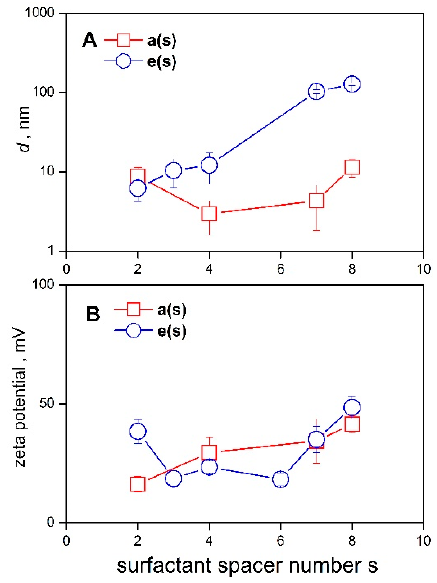
Figure 5. A : Micelle hydrodynamic diameter d of a(s) and e(s) gemini surfactants plotted as a function of surfactant spacer number s , at the surfactant concentration 6 × cmc . B : Zeta potential of a(s) and e(s) gemini micelles plotted as a function of surfactant spacer number s . Zeta potential of a(s) and e(s) gemini micelles was determined at the surfactant concentration 6 × cmc and 15 × cmc , respectively.